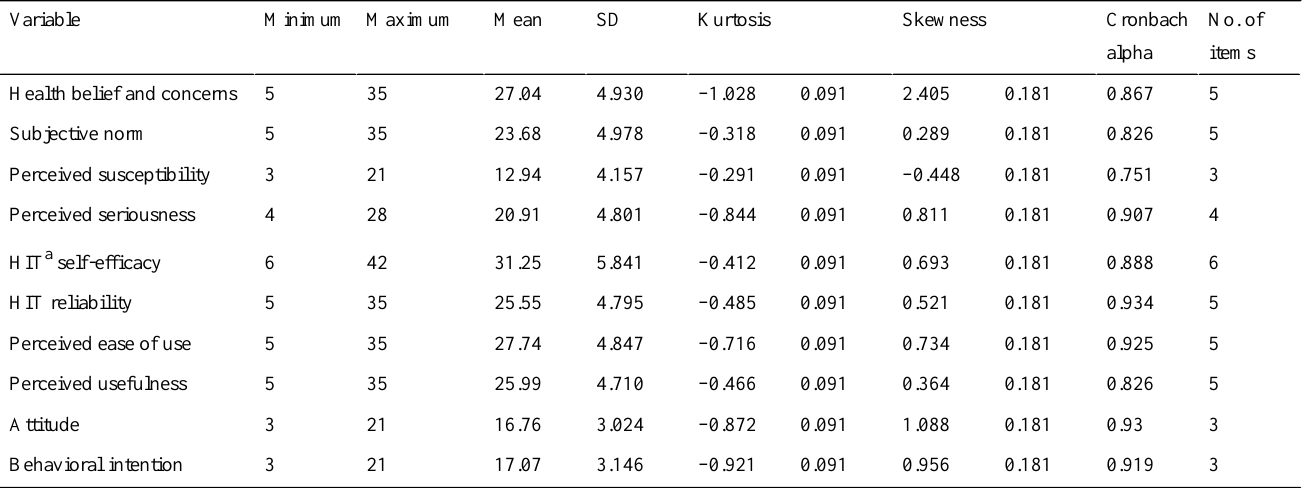
Table 3. Descriptive statistics of the latent variables and the reliability coefficients (N = 728 for all variables).